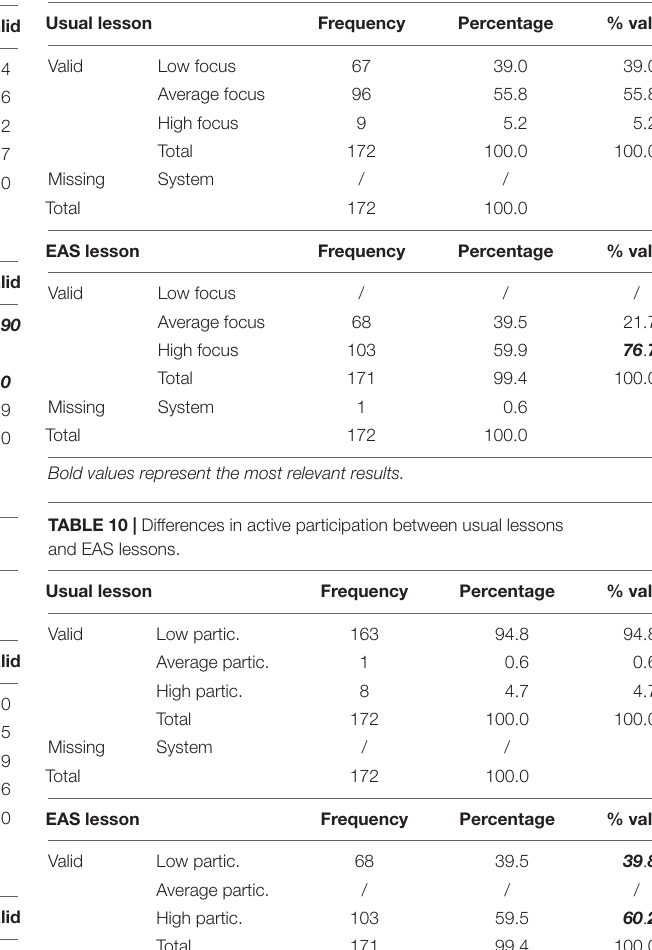
TABLE 7 | Proxemics differences between usual lessons and EAS lessons_position.